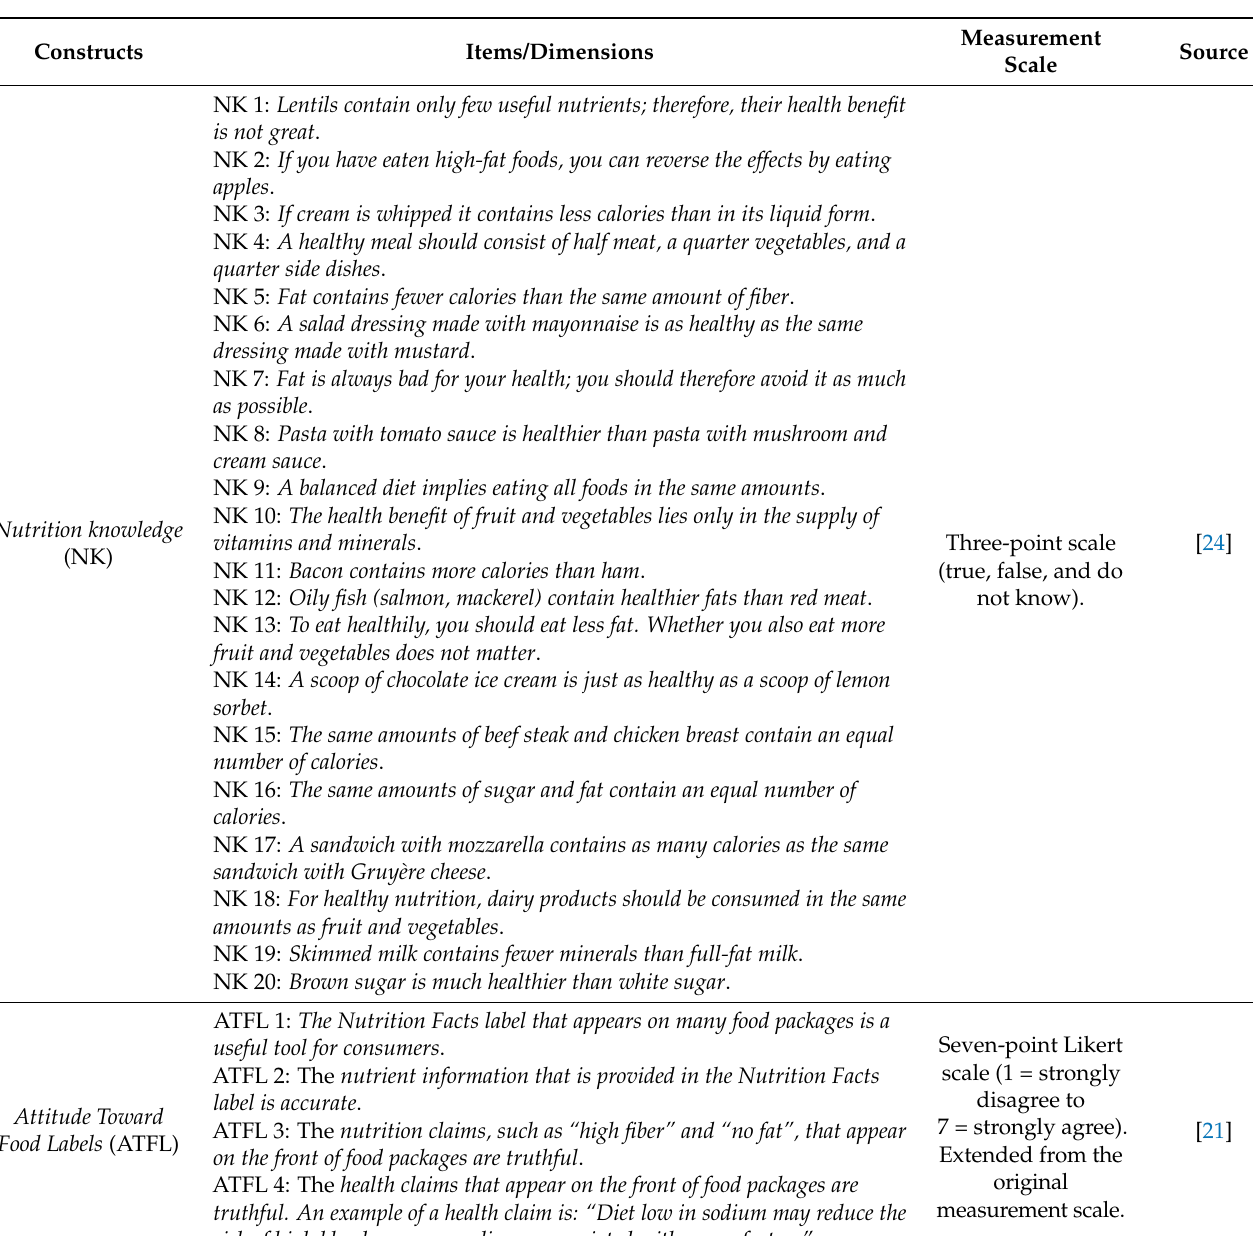
Table A1. Dimensions, items, measurement scale, and source of the constructs assessed in the